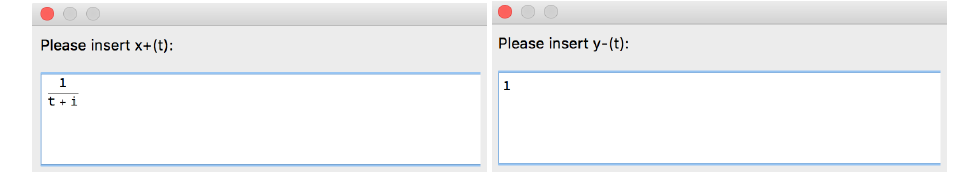
Figure 13. Part of the structure of the [SInt] algorithm corresponding to the input of x + and y − . The [SInt] algorithm gives the incorrect output presented in Figure 14 since x + / ∈ R ( T ) .